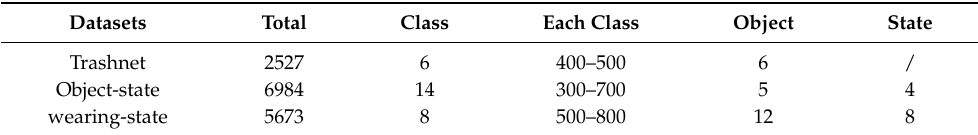
Table 2. Comparison of our proposed two datasets and one common dataset,